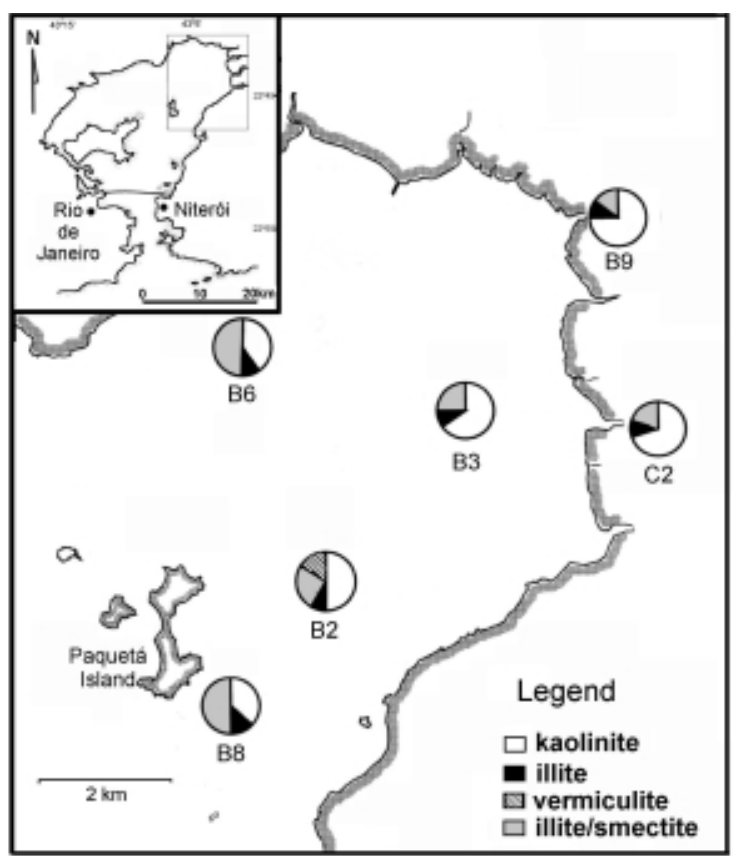
Fig. 5 – Clay mineral distribution in bottom sediments of northeastern sector of the bay (relative percent of 2 µm grain-size